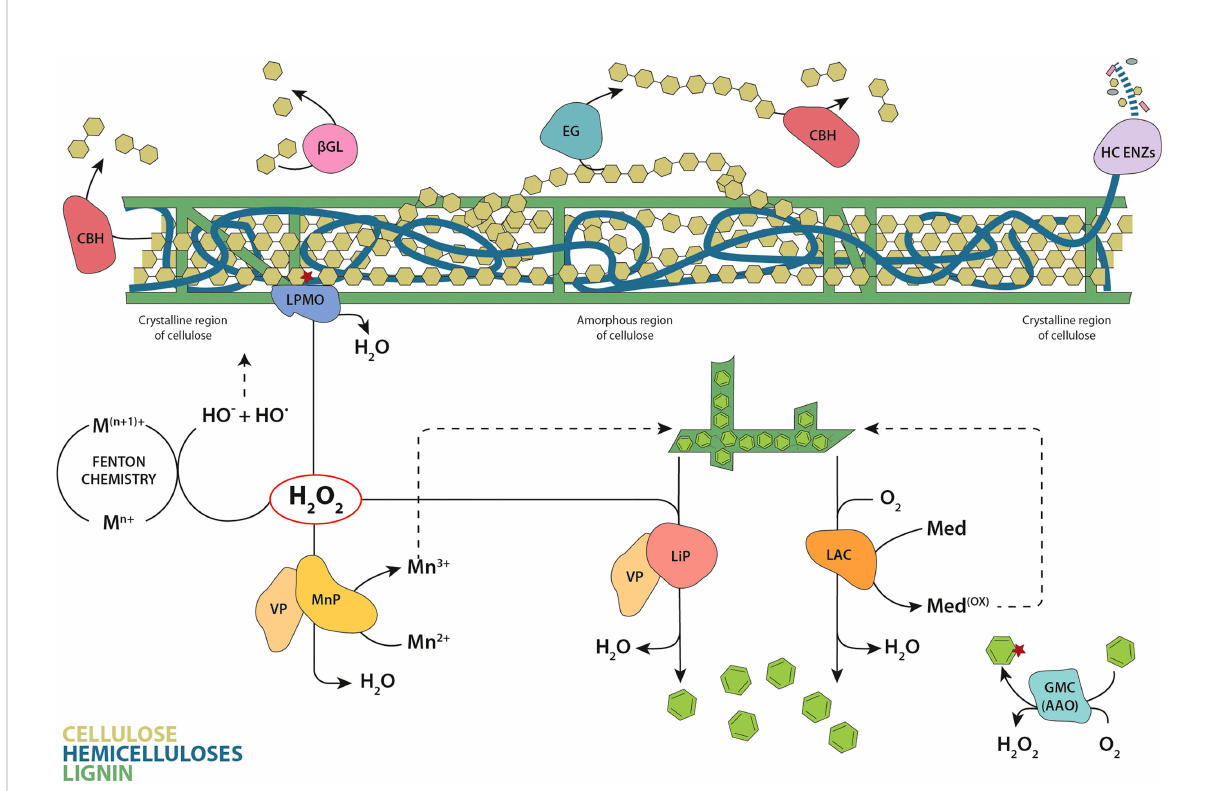
FIGURE 3 Classic model of enzymatic plant cell wall degradation. Hydrolysis of cellulose involves cellobiohydrolases (CBH) that hydrolyze the cellulose chains from reducing and non-reducing ends, endoglucanases (EG) that cut randomly inside the chains, and b -glucosidases ( b GL) that convert the cellobiose units produced by CBHs to glucose. The oxidation of the crystalline cellulose surface by LPMOs results in an internal chain cleavage. The wide set of enzymes involved in the degradation of hemicellulose are represented by a single designation (HC ENZs). Laccases (LAC) directly oxidize the phenolic lignin moiety, or the nonphenolic lignin via redox mediators. Within peroxidases, lignin peroxidases (LiP) are able to oxidize directly the major nonphenolic lignin moiety, manganese peroxidases (MnP) oxidize Mn 2+ to Mn 3+ (the diffusible Mn 3+ chelates oxidize the phenolic moiety of lignin) and versatile peroxidases (VP) catalyze the reactions described for both LiPs and MnPs. Brown-rot fungi also degrade cellulose and hemicellulose via in vivo Fenton chemistry. The glucose-methanol-choline oxidase/dehydrogenase superfamily (GMC) are exempli fi ed by the aryl-alcohol oxidases (AAO) that generate hydrogen peroxide in the redox cycling of aromatic metabolites. Cellulose chains are depicted as linked olive-green hexagons, hemicelluloses in blue and lignin in dark green. Released lignin units and aromatic metabolites are represented as green